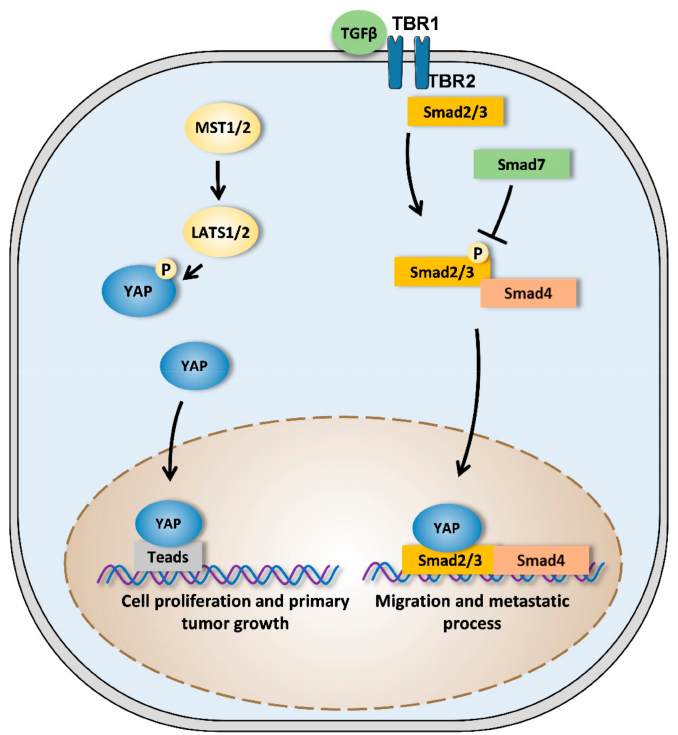
Figure 3. Crosstalk between YAP signaling pathway and both TEAD and TGF- β pathways. When the Hippo signaling pathway is inactive, MST1 / 2 (mammalian STE20-like kinase 1 / 2) activates LATS1 / 2 (large tumor suppressor 1 / 2) proteins. LATS1 / 2 then phosphorylates YAP (yes-associated protein) which is retained in the cytoplasm or is degraded by the proteasome. When the Hippo signaling pathway is inactive, YAP is not phosphorylated and translocates to the nucleus where it can exert its transcriptional activity by binding to TEAD (transcriptional enhanced associate domain). YAP regulates the expression of specific targets involved in the cellular proliferation and thus in the primary tumor